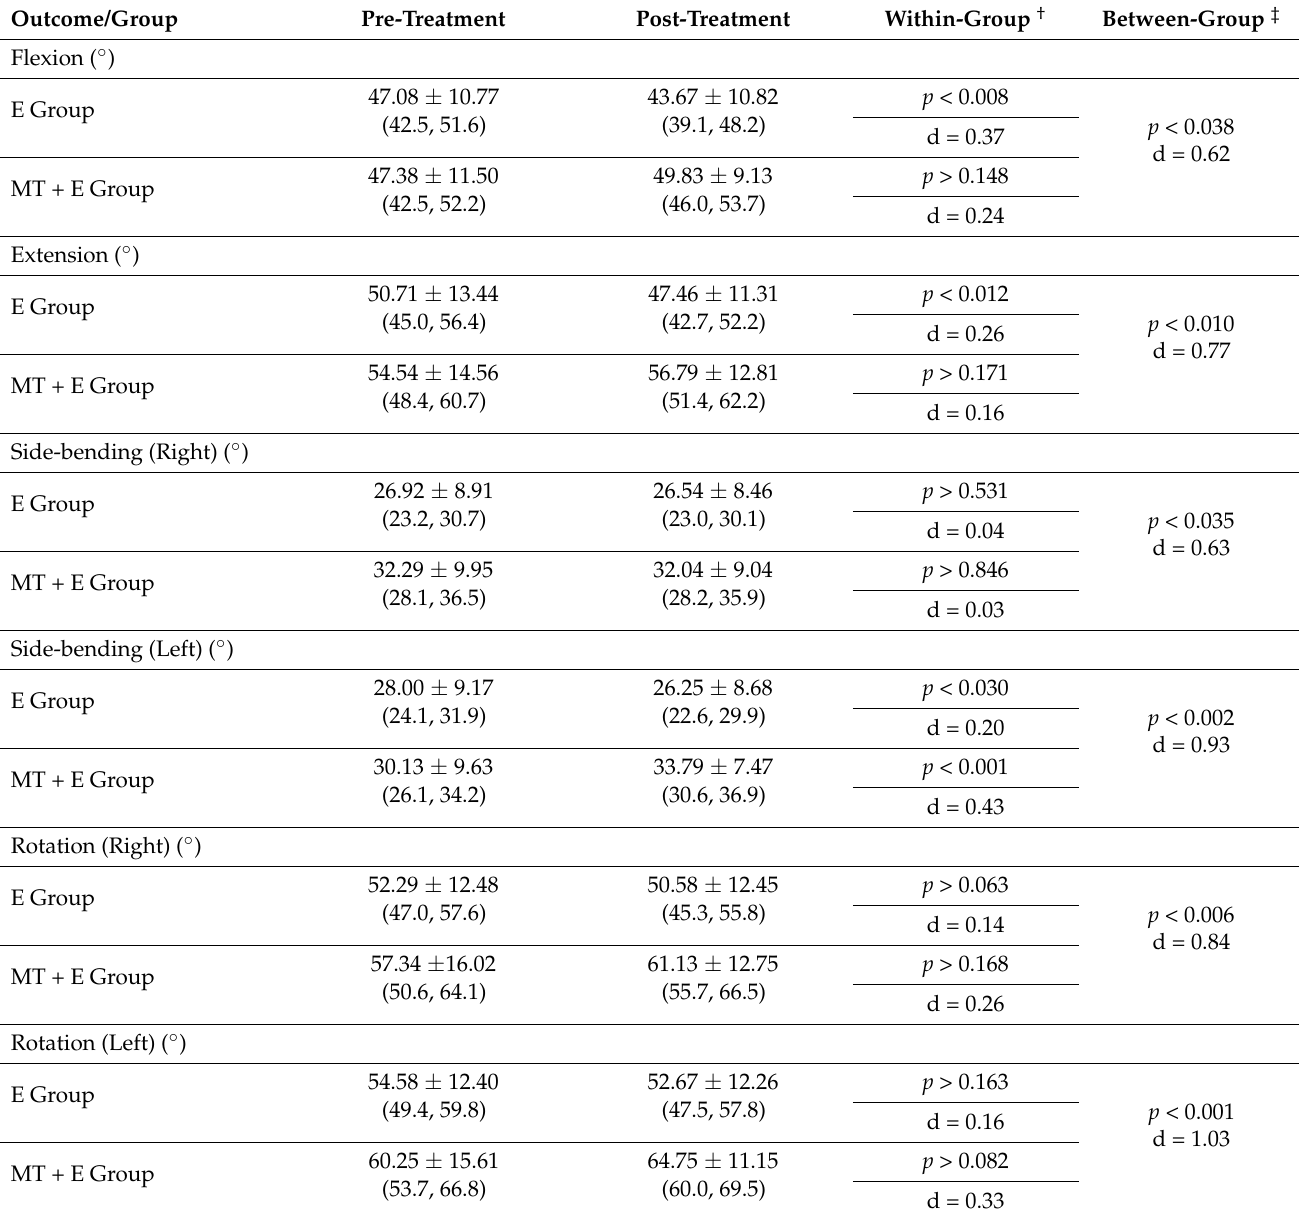
Table 3. Pre- and post-treatment in cervical range of motion